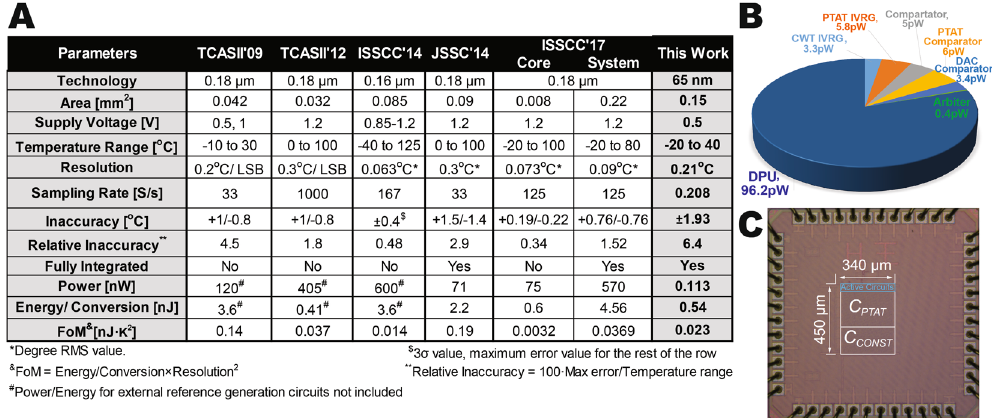
Figure 5. Summarized experimental results of the temperature sensor and the fabricated temperature sensor chip. ( A ) Comparison with prior-art. ( B ) Power breakdown of the proposed temperature sensor. ( C ) Micrograph of the proposed fully integrated temperature